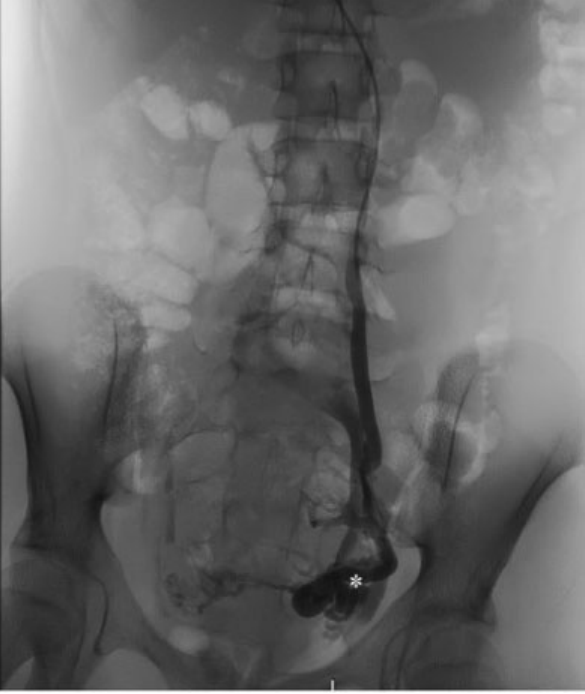
Fig. 3 Venography image showing a group of pelvic varicose veins (white star) with a maximum caliber of 8 to 9mm, draining into the left ovarian and internal iliac veins.